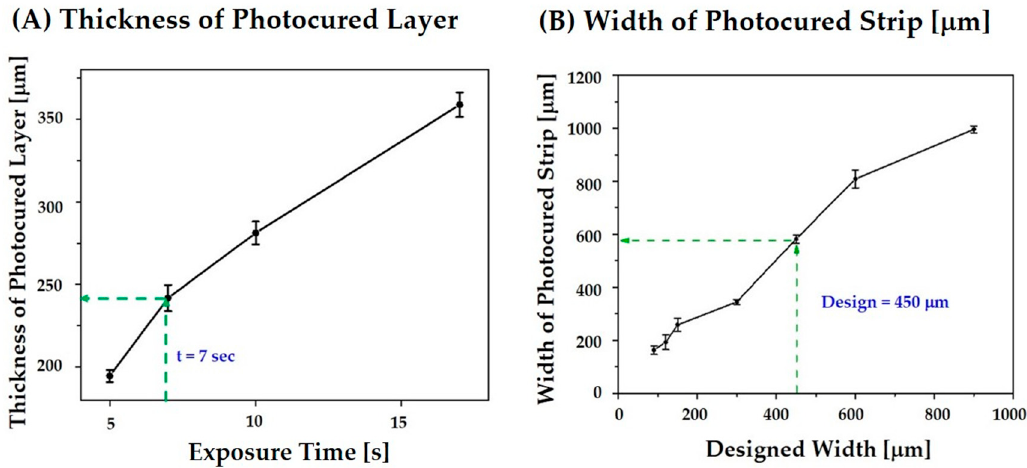
Figure 6. ( A ) Thicknesses of the photo cured layers as a function of exposure time at a constant UV power of 16 mW and ( B ) measured widths of the photo cured strips as a function of their designed widths after photo curing for 7 s.